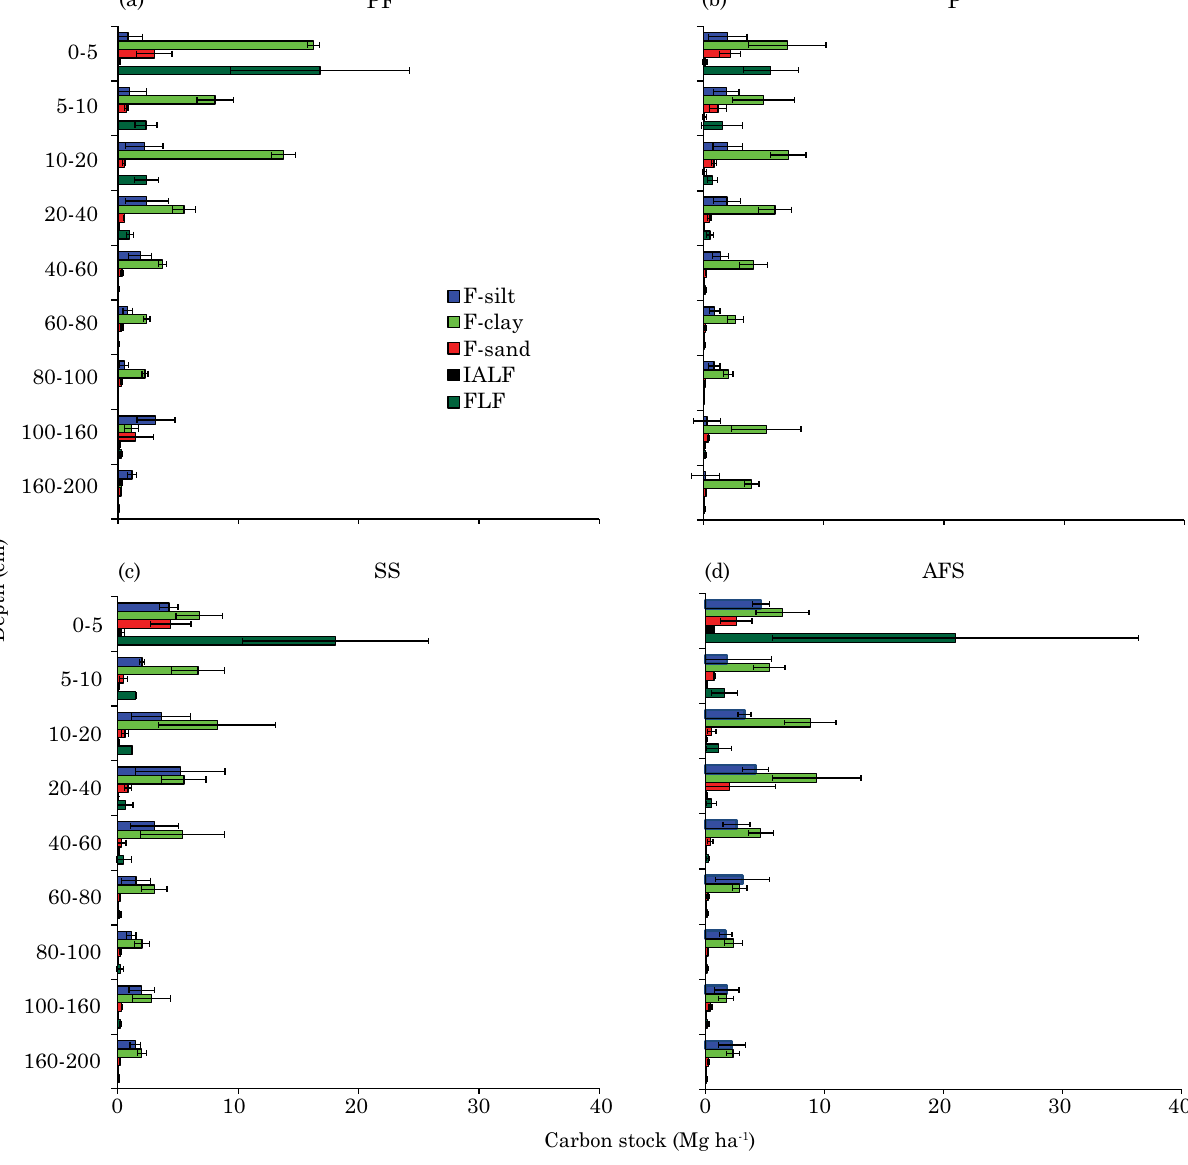
Figure 1. Carbon stocks in light and heavy fractions at different depths in primary forest (PF) (a), pasture (P) (b), secondary succession (SS) (c), and agroforest system (AFS) (d) in Central Amazonia. The bars represent the stocks of carbon at each depth in the different fractions, by depth, with their respective standard deviation. F-clay: clay fraction; F-silt: silt fraction; F-sand: sand fraction; FLF: free light fraction; IALF: intra-aggregate light